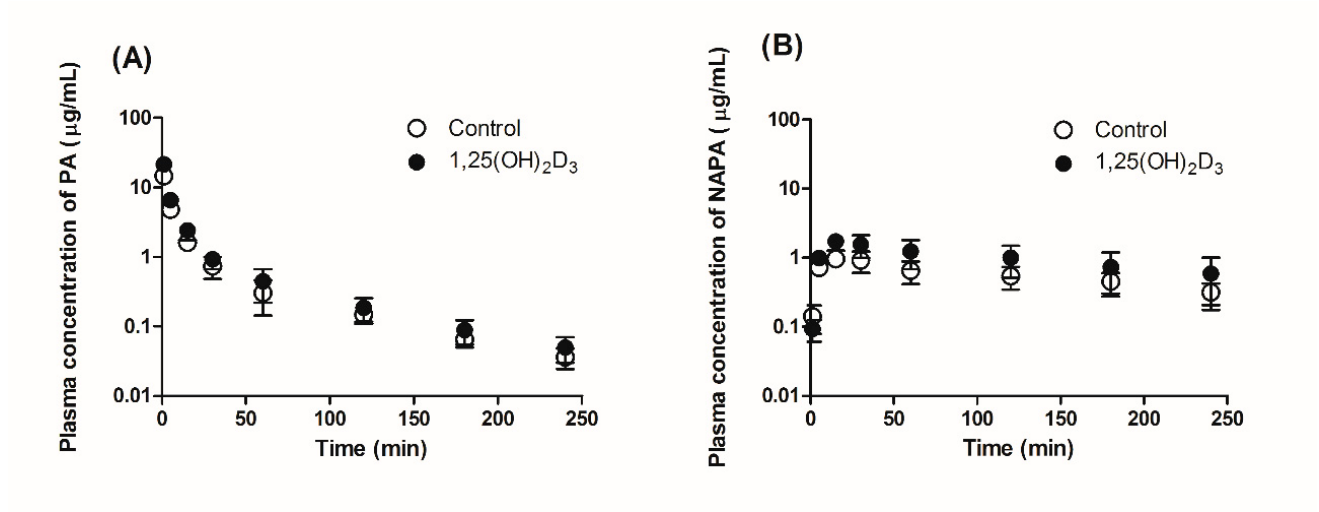
Figure 3. Plasma concentration-time profiles of ( A ) PA and ( B ) NAPA following intravenous administration of 10 mg/kg PA HCl to control (open circles) and 1,25(OH) 2 D 3 -treated rats (closed circles) ( n = 9 per group). Table 1. Pharmacokinetic parameters of PA and NAPA following intravenous administration